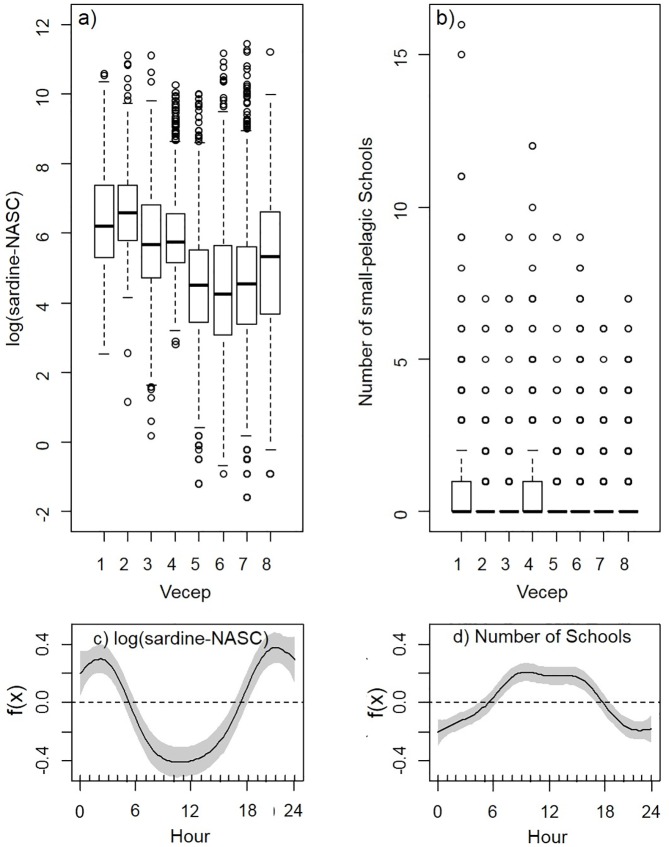
Boxplots and Generalized Additive Model (GAM) analysis of sardine-NASC and Schools for each Vecep cruise.Boxplots of (a) sardine-NASC and (b) Schools for each Vecep cruise, and GAM analysis of (c) log(sardine-NASC) and (d) number of Schools vs. hour. Regardless of the season, the first four surveys showed higher averages of sardine-NASC than the last four surveys; however, the number of schools didn’t show differences between surveys. The GAM analyses show the typical diel patterns of aggregation of sardines. The backscattering strength of sardine is weaker during day time, because they are concentrated into school of fish; the opposite occurs during night time.